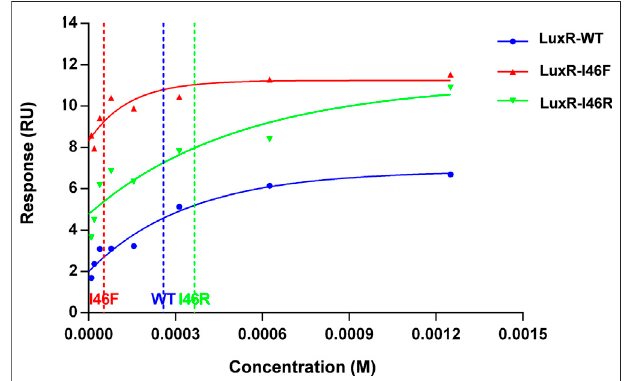
FIGURE 3 | Surface plasmon resonance characterization of binding of 3OC6-HSL to maltose-binding protein fusions of residues 1 – 179 of WT V. fi scheri LuxR, I46F and I46R mutants.